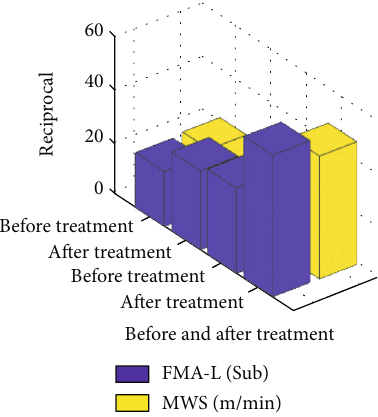
Figure 6: Comparison of FMA-Ll and MWS between the two groups before and after treatment ( x ± s